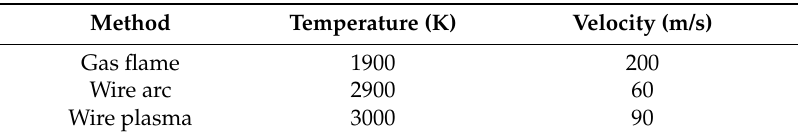
Table 3. Measured temperatures and velocities of spray droplets ejecting from three different thermal spray guns.